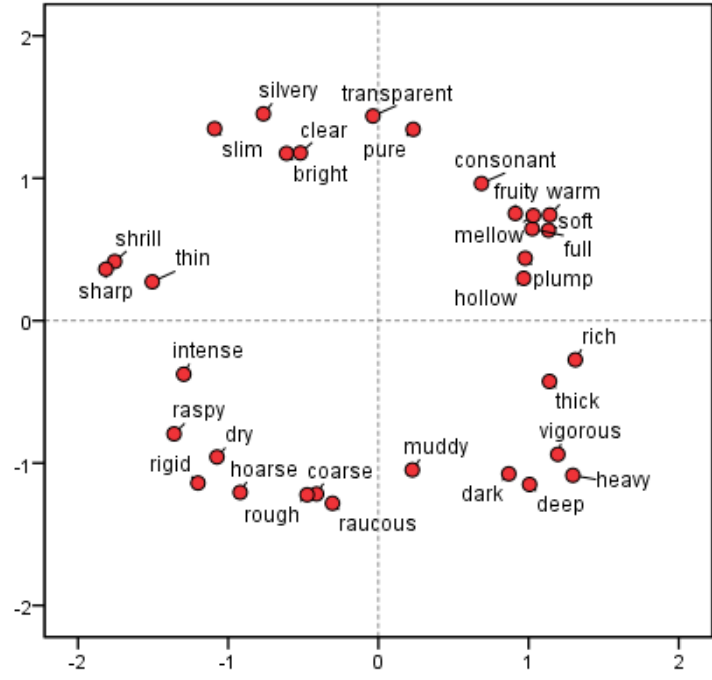
Appl. Sci. 2020 , 10 , 789 Figure 2. The distance relationship between the 32 evaluation terms. Figure 2. The distance relationship between the 32 evaluation terms.